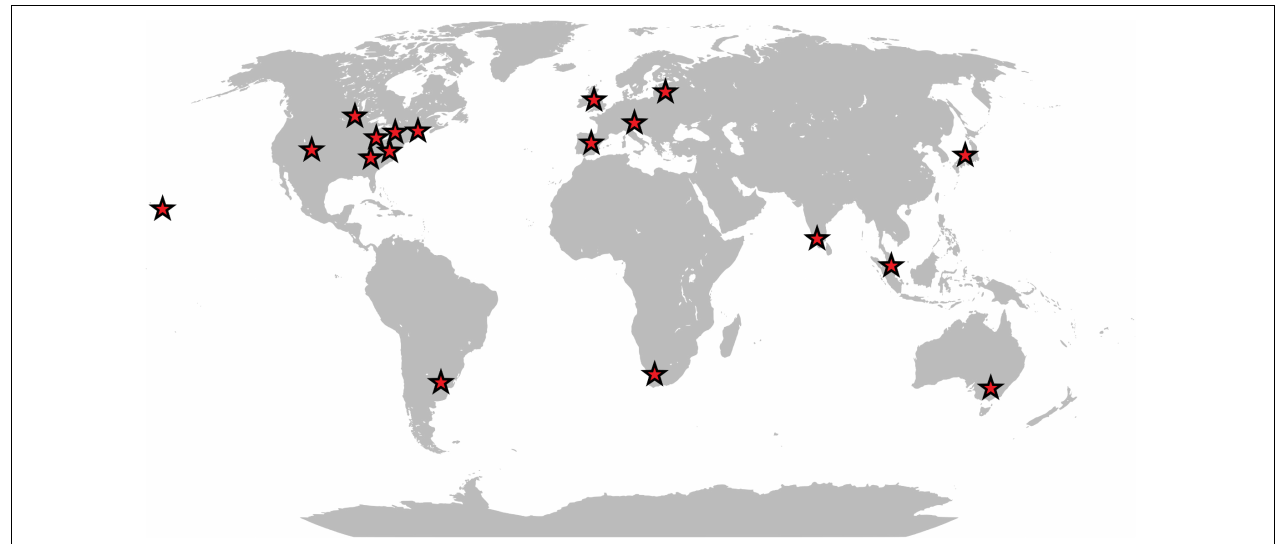
FIGURE 1 | Schematic map showing the geographic distribution of reported human infections caused by W. chitiniclastica .